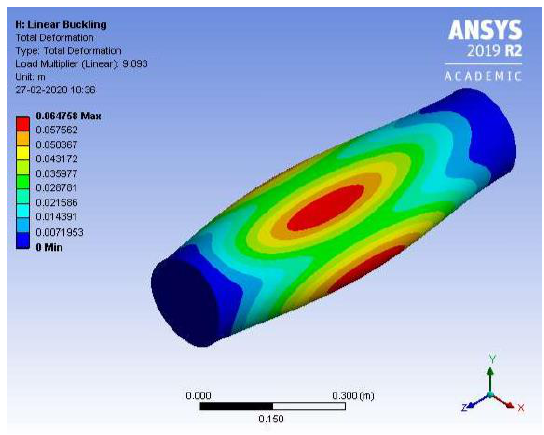
Figure 4. Linear buckling analysis for the unstiffened shell.